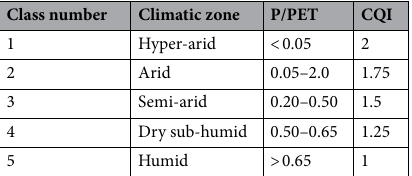
Table 11. Classification of climatic quality index